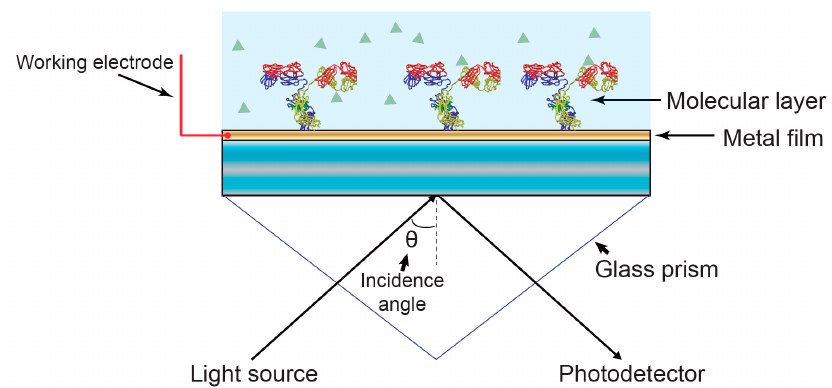
Figure 3. Schematic diagram of electrochemical-SPR (EC-SPR). The gold substrate that carries the optical surface mode is simultaneously used as the working electrode, allowing simultaneous optical and electrochemical interrogation. Typically, the fluidic manifold also includes counter and reference electrodes to form a complete three-electrode electrochemical cell.